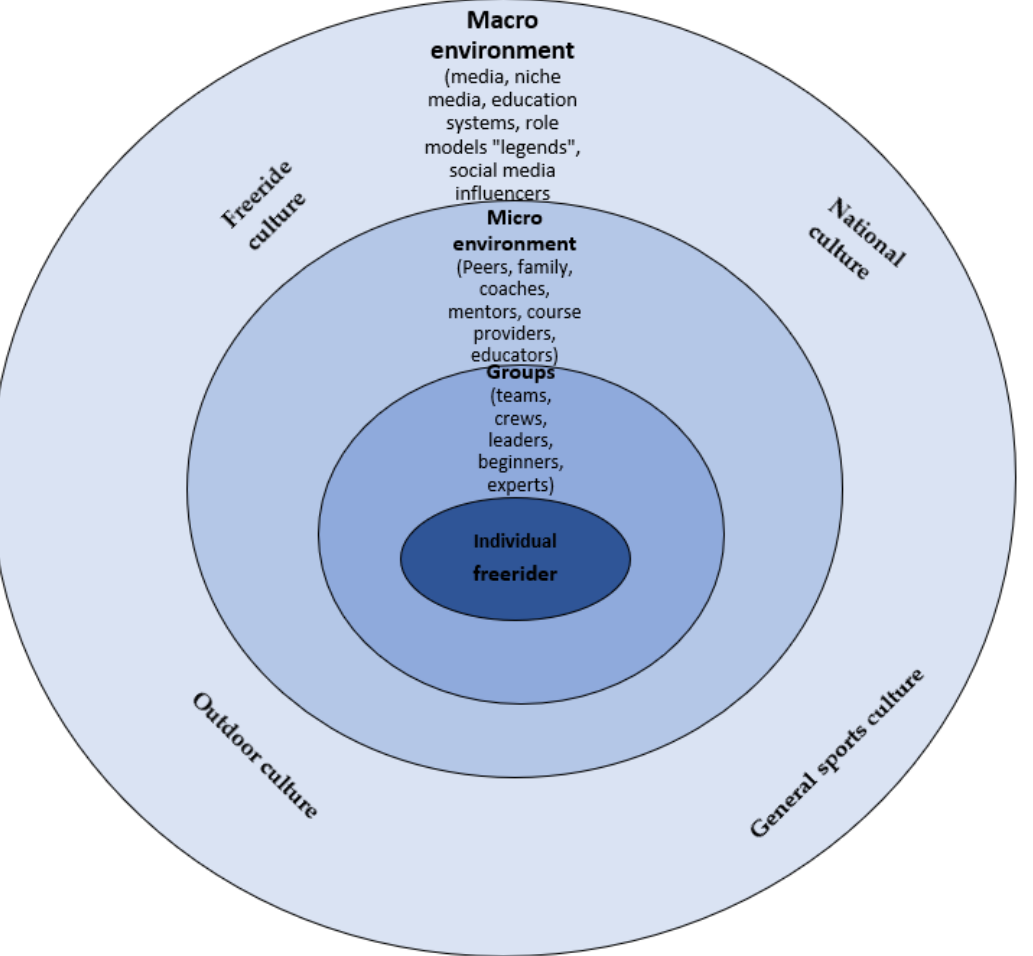
Figure 3. An ecological context of adventure sport participant (exemplified by a freeride snowboarder or